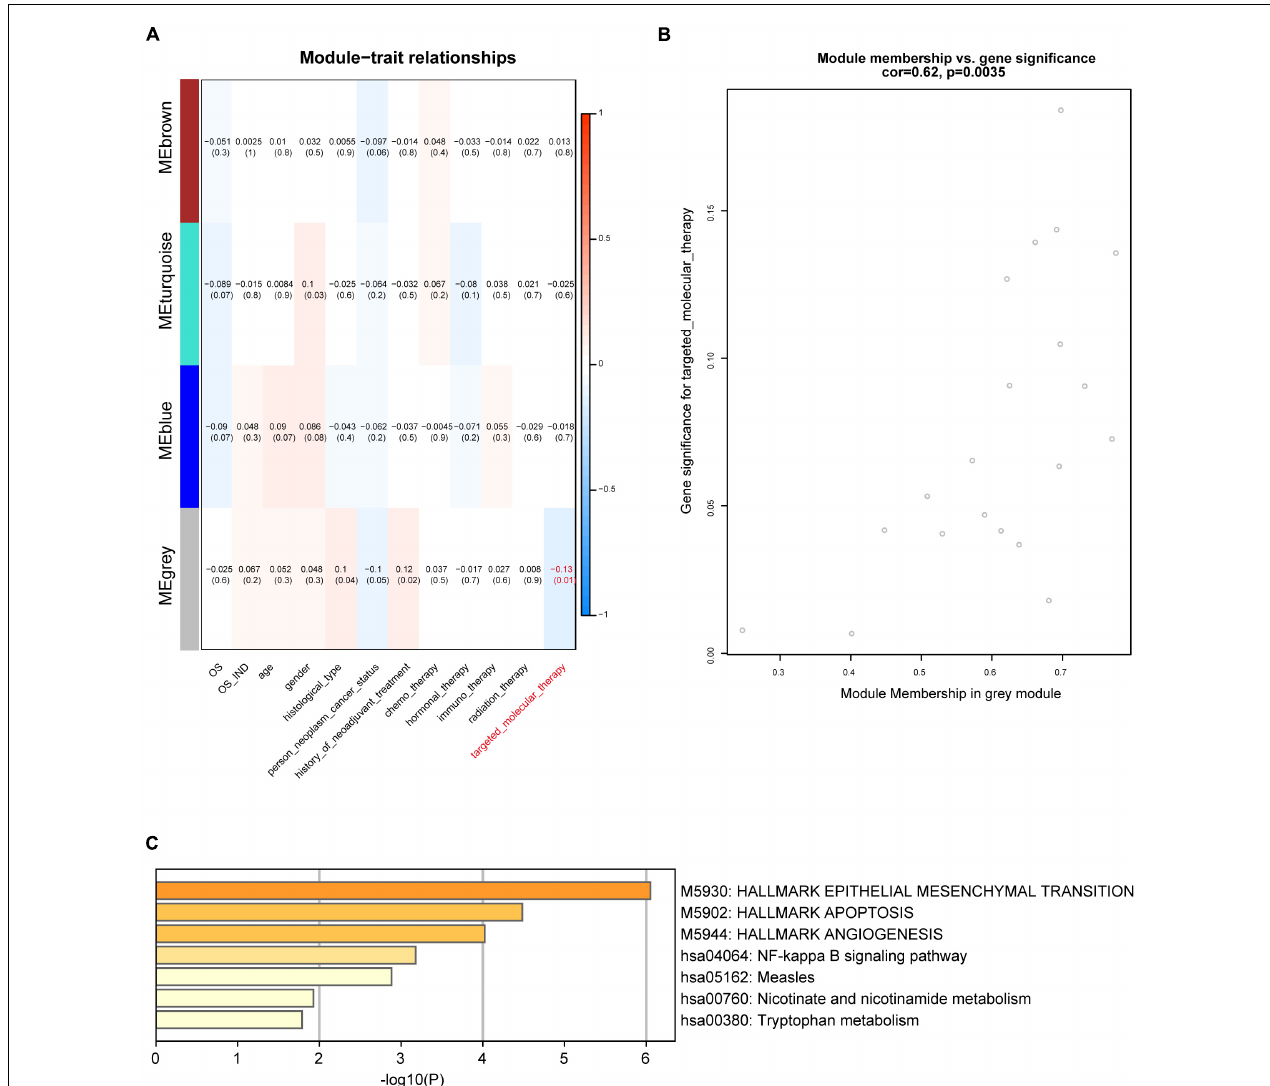
FIGURE 3 | Module-trait associations. (A) Module-trait relationships. Each row represents a module when each column indicates a clinical trait. Every cell shows the correlation coefficient and P -value. (B) Dot plot showing the gray module’s genes significance and module membership in targeted molecular therapy. (C) Enrichment analysis of differentially expressed genes in the gray